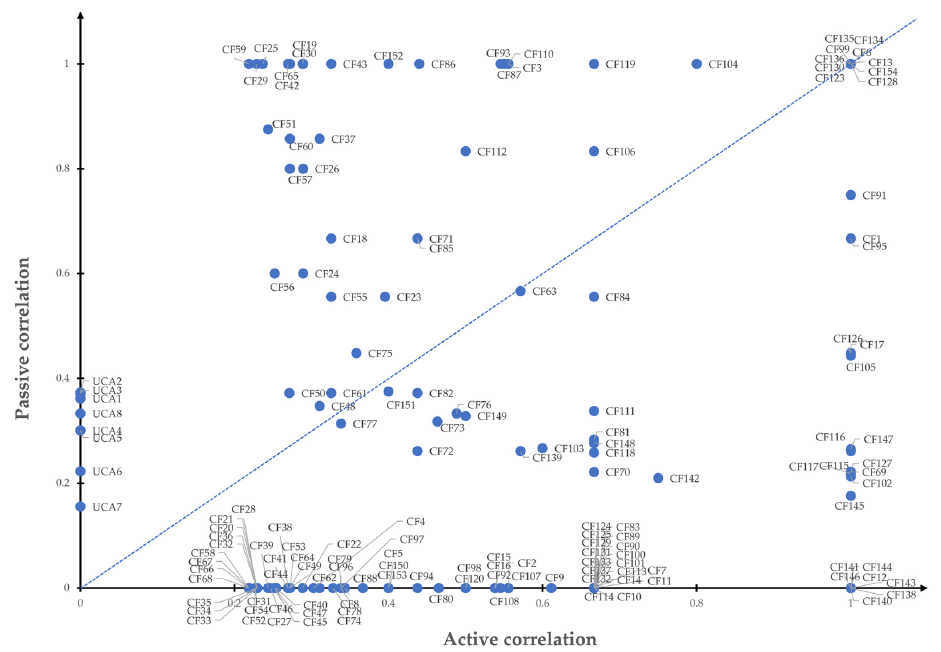
Figure 6. Active and passive correlation of UCAs and causal factors.